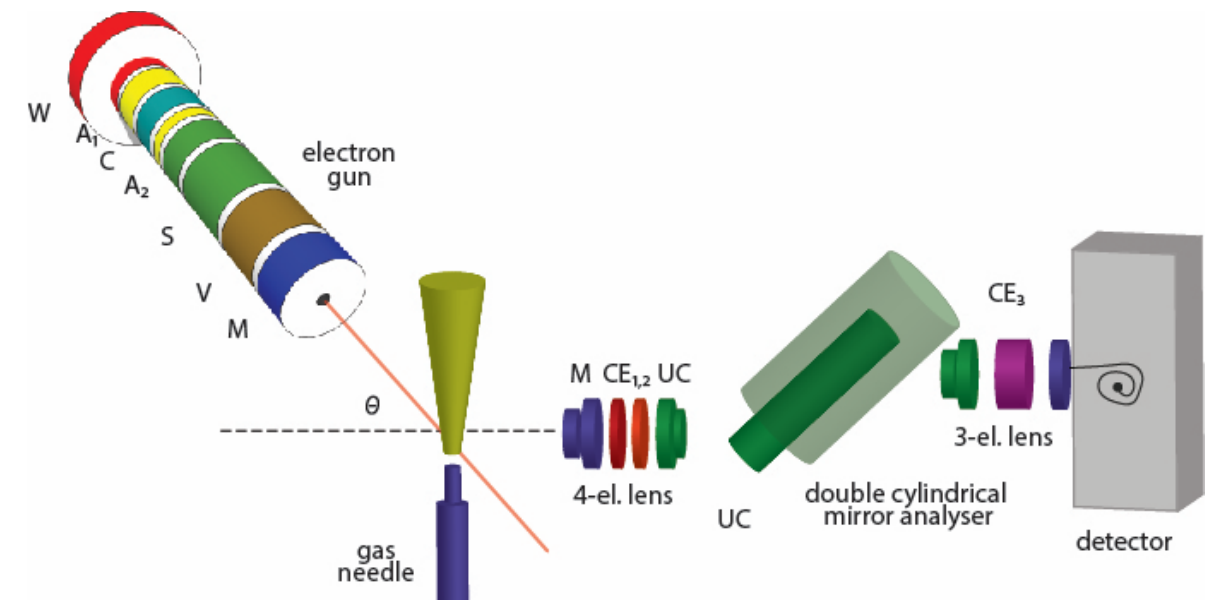
Figure 2. Schematic drawing of the experimental set-up.